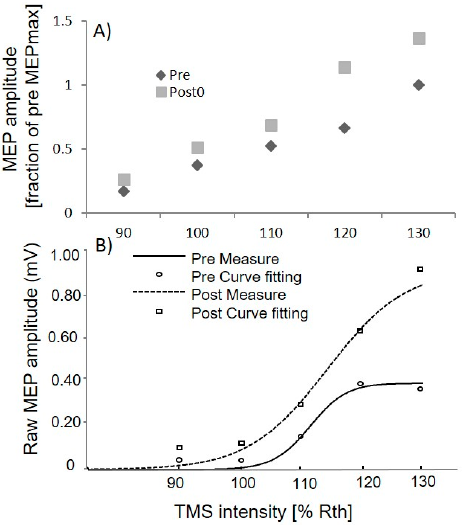
Figure 2. Motor evoked potential (MEP) recruitment curve prior to, and following the full spinal manipulation intervention for lower limb muscle (TA): ( A ) input–output properties of the TA MEP; and ( B ) raw and fitted TA MEP recruitment curve for n = 1.